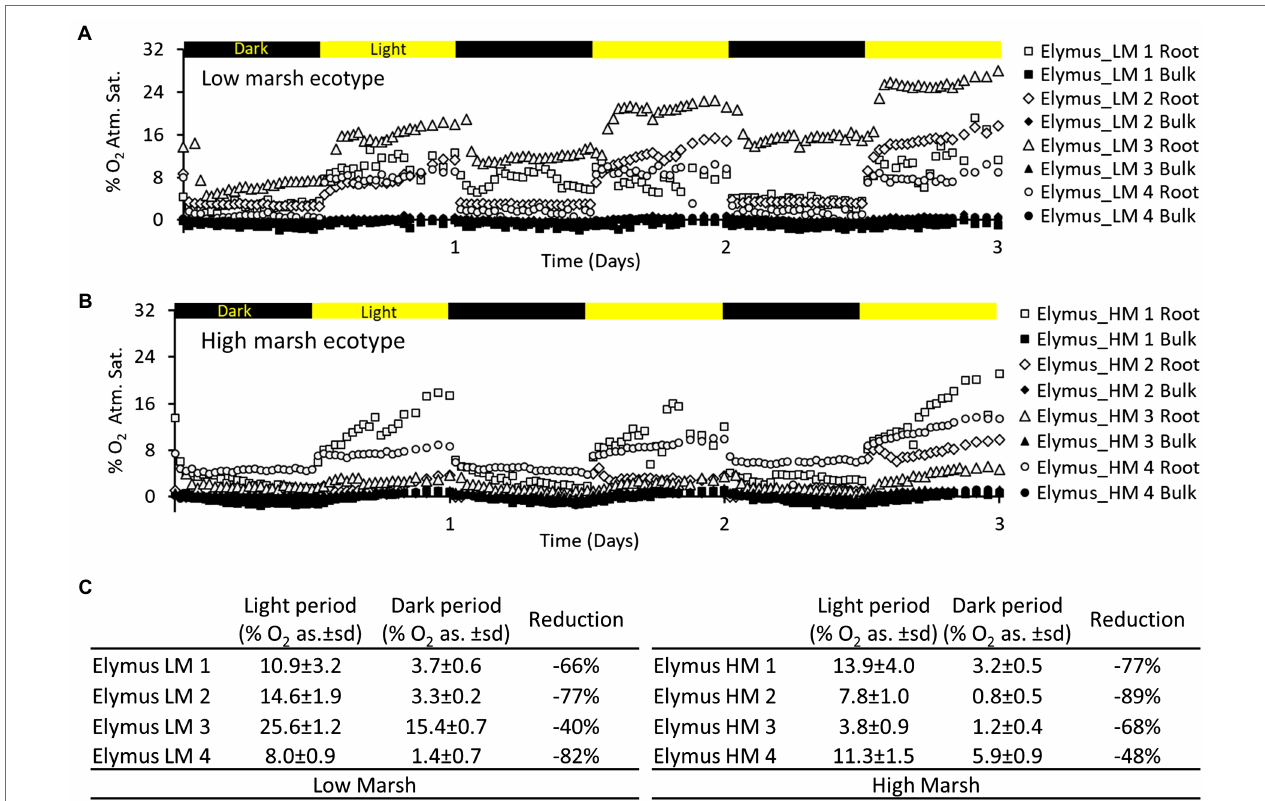
FIGURE 4 | Oxygen dynamics in selected oxic root zones of the E. athericus – low-marsh ecotype (A) and high-marsh ecotype (B) during three light–dark periods (12 h/12 h). The location of the oxic root zones is depicted in the optode images of Figures 2 , 3 . (C) Table showing O 2 concentrations [% O 2 atm. sat.(as.)] in selected root zones of the low- and high-marsh ecotype, calculated as an average of the light period (2.5–3 d) and the preceding dark period (2–2.5 d), respectively; ±sd refers to the standard deviation ( n = 24). “Reduction” shows the percentage reduction in the average concentration of O 2 between light and dark